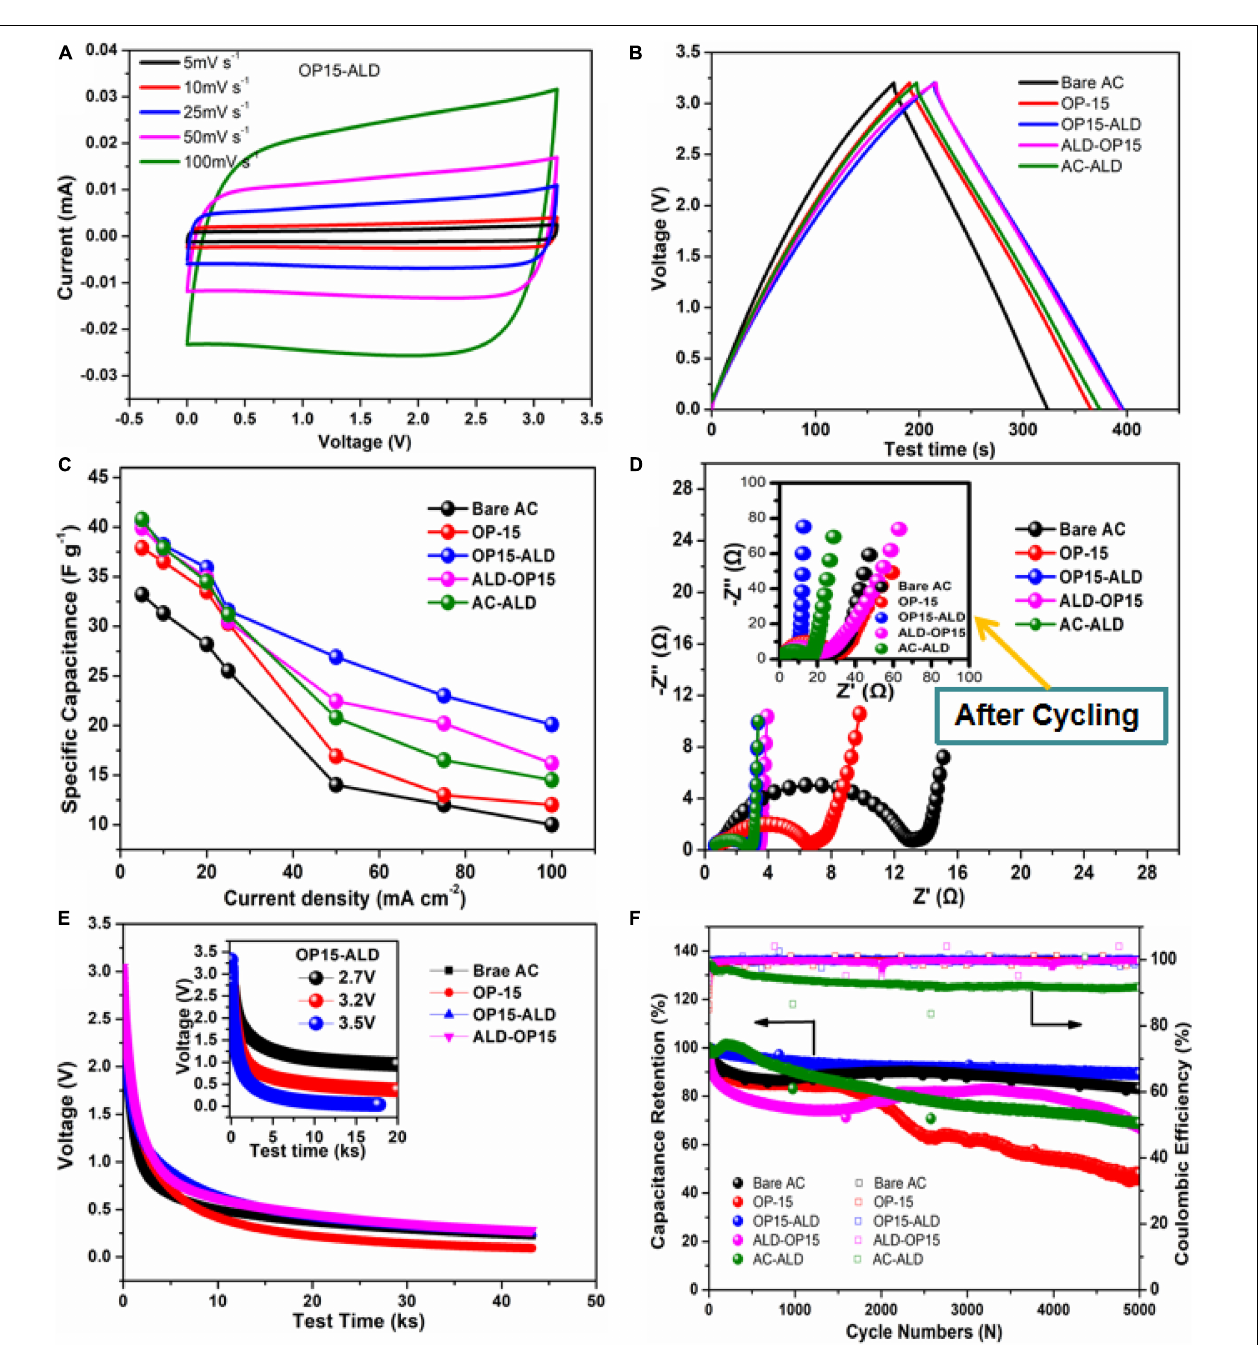
FIGURE 7 | (A) CV curves of OP15-ALD; (B) A comparison GCD curves at 5 mA cm - 2 of OP-15, OP15-ALD, ALD-OP15, and AC-ALD; (C) Rate capacitance of OP-15, OP15-ALD, and ALD-OP15; (D) Electrochemical impedance spectrum of Bare AC and OP-x (insert is the EIS after 5,000 cycles); (E) Self-discharge behavior (insert is OP15-ALD self-discharge after charging at 2.7, 3.2, and 3.5 V); and (F) Cyclic retention (solid circles) and Columbic efficiency (open circles) of 4 different